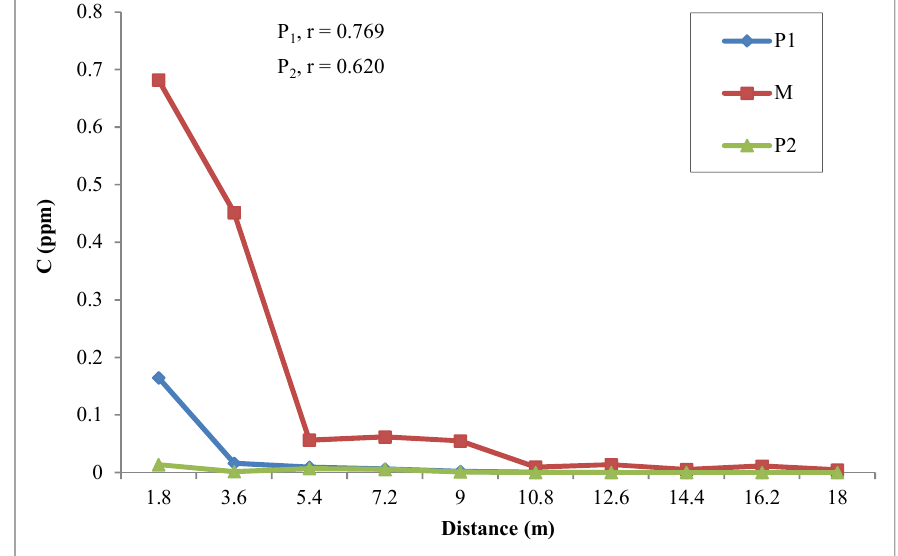
Figure 9. Measured and Predicted Concentrations against Distance for the month of January.